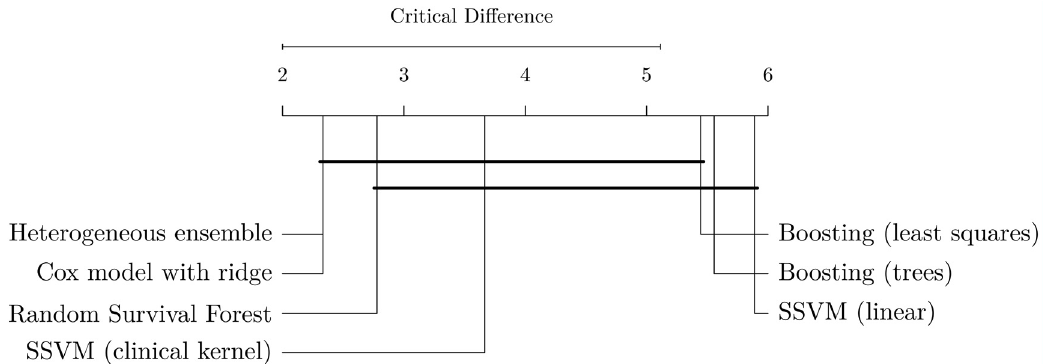
Figure 5. Comparison of methods based on experiments in Figure 3 with the Nemenyi post-hoc test 34 . Methods are sorted by average rank (left to right) and groups of methods that are not significantly different are connected ( p -value